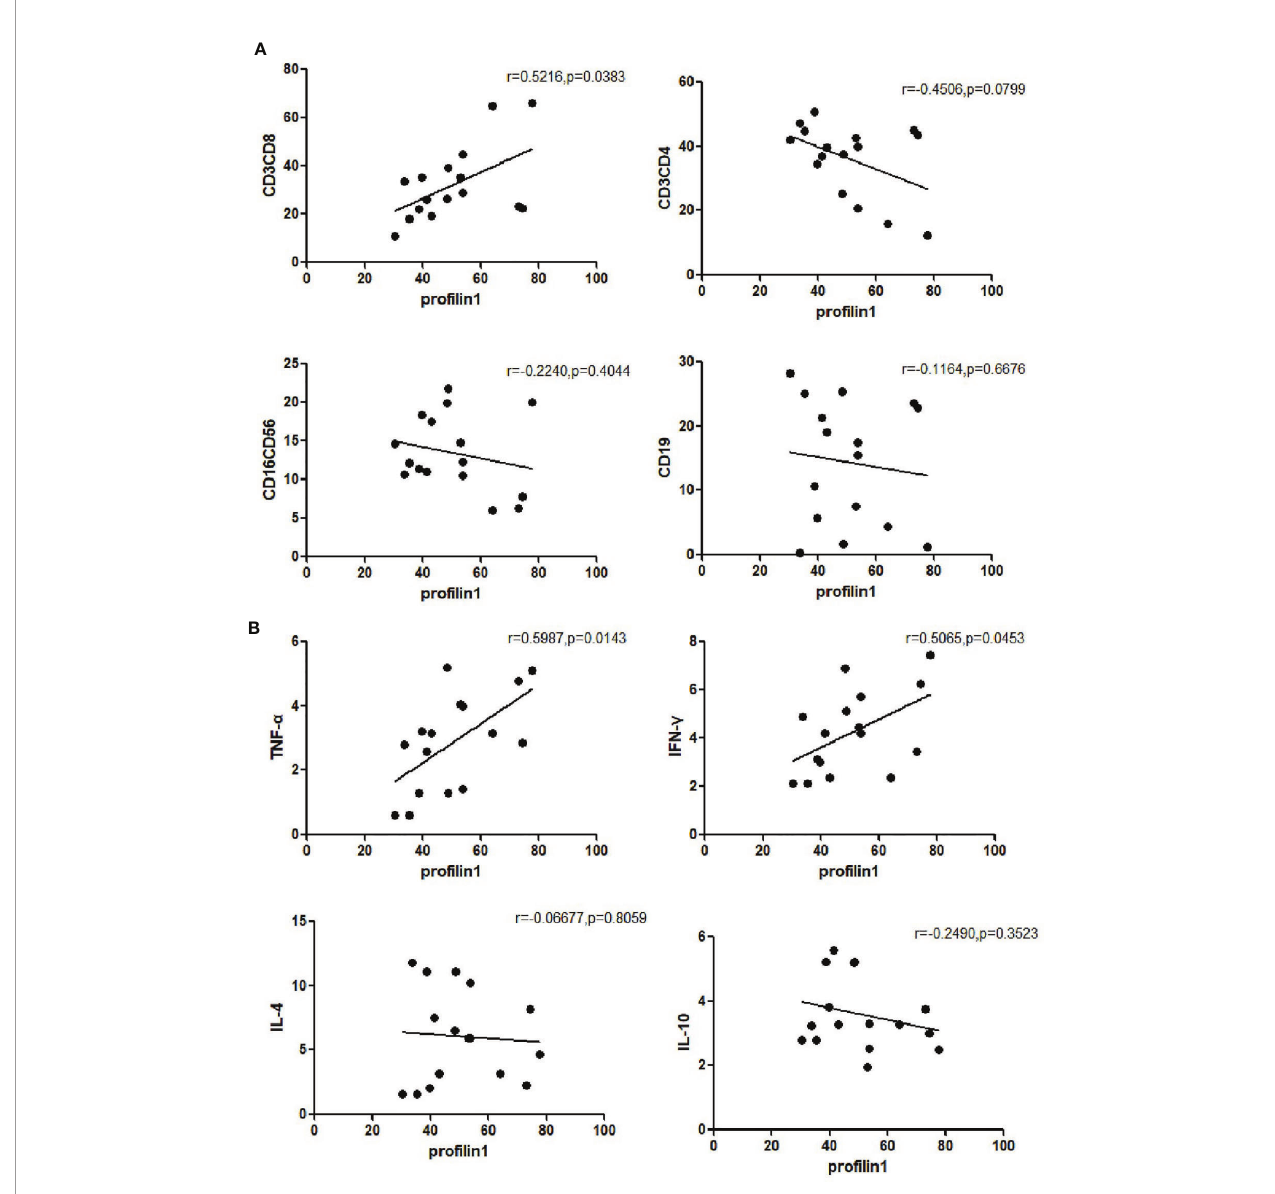
FIGURE 3 | Frequency of pro fi lin 1 was associated closely with the number of immune cells (A) and the concentration of cytokine levels (B) in patients with untreated SAA